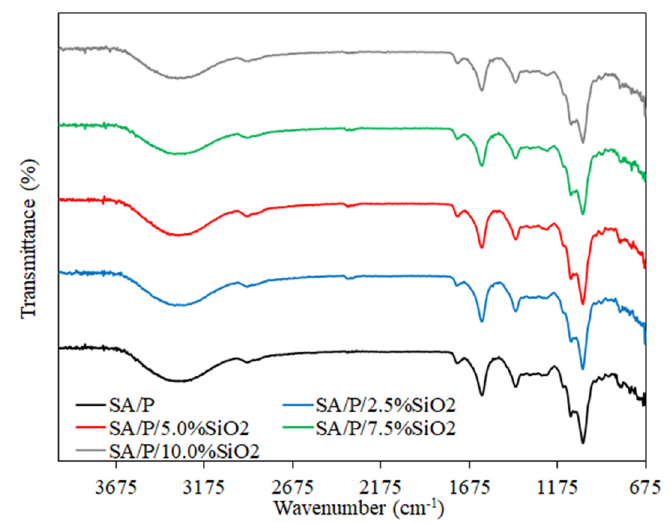
Figure 2. FT ‐ IR spectra of SA/P and SA/P/SiO 2 films. Figure 2. FT-IR spectra of SA/P and SA/P/SiO 2